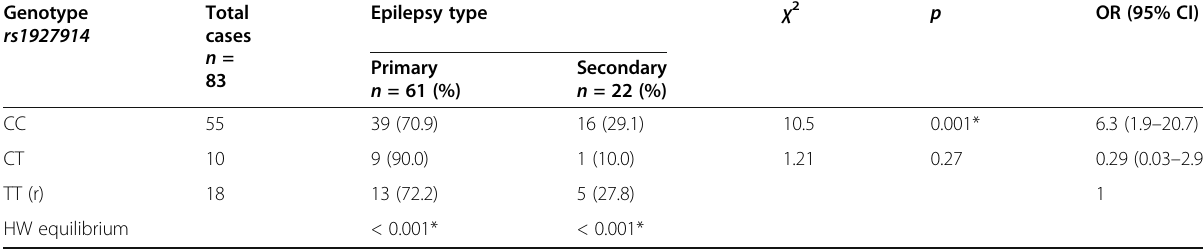
Table 4 Association between TLR genetic polymorphism rs1927914 and epilepsy type Genotype rs1927914